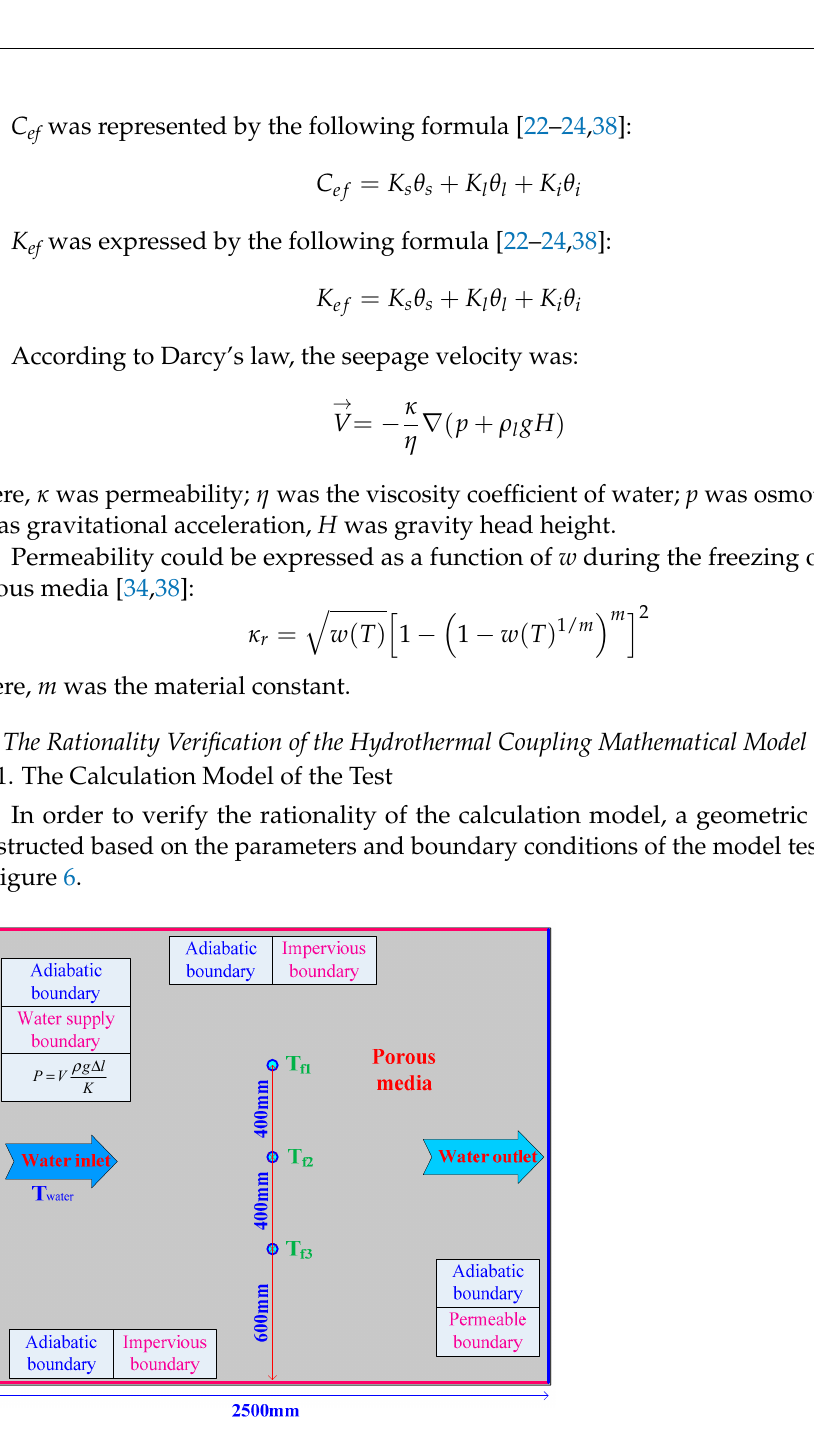
Figure 6. Geometric model and boundary conditions of numerical calculation.